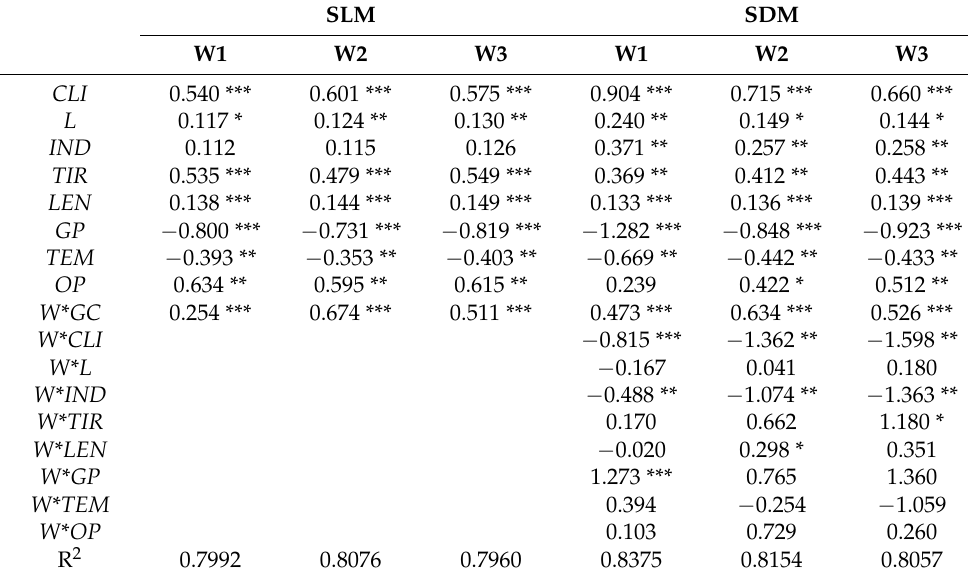
Table 2. The influencing factors analysis by SLM and